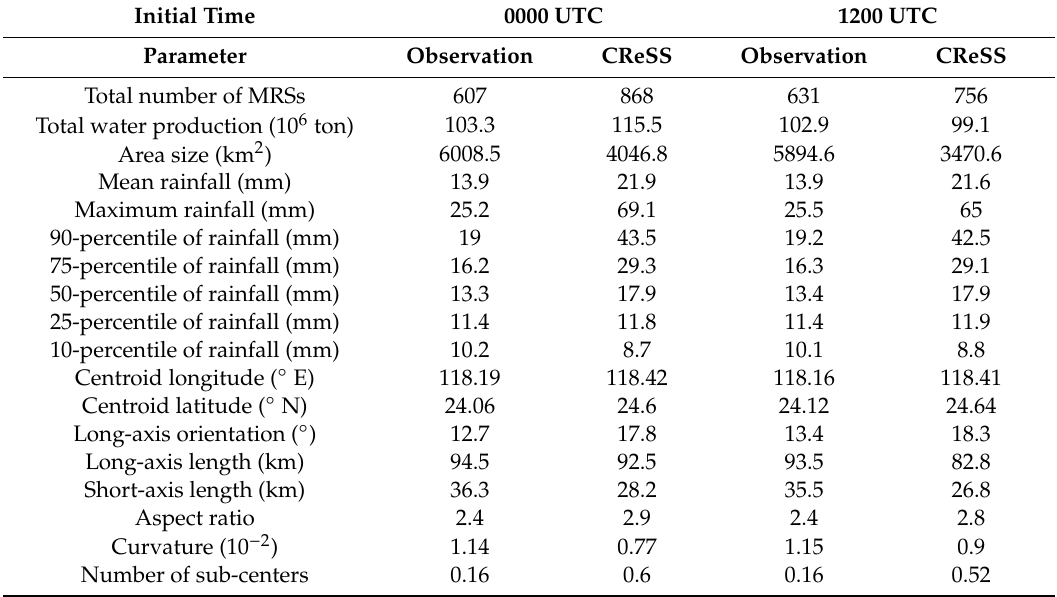
Table 5. Mean value of major attributes of MRSs (from data at 3-h intervals) in observation and CReSS forecasts at the range of 12–36 h, initialized daily at 00:00 or 12:00 UTC. For each MRS, the attributes are averaged during its